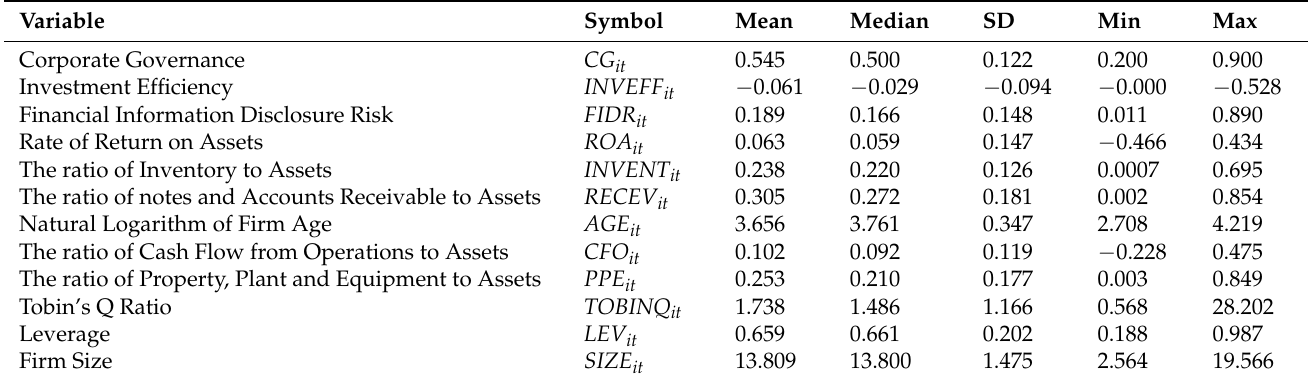
Table 3. Descriptive statistics of the research variables.